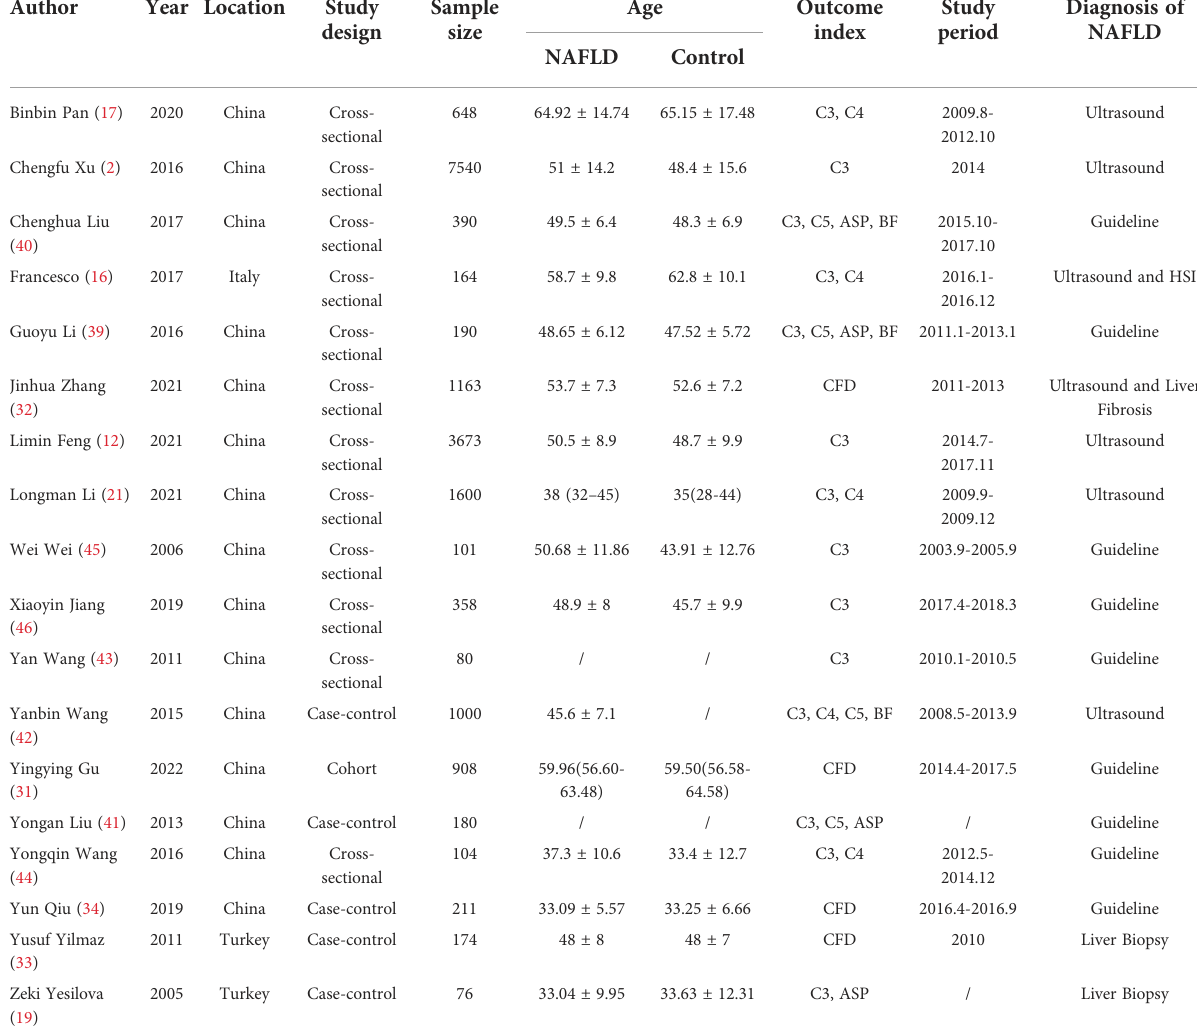
TABLE 1 Basic characteristics of the included